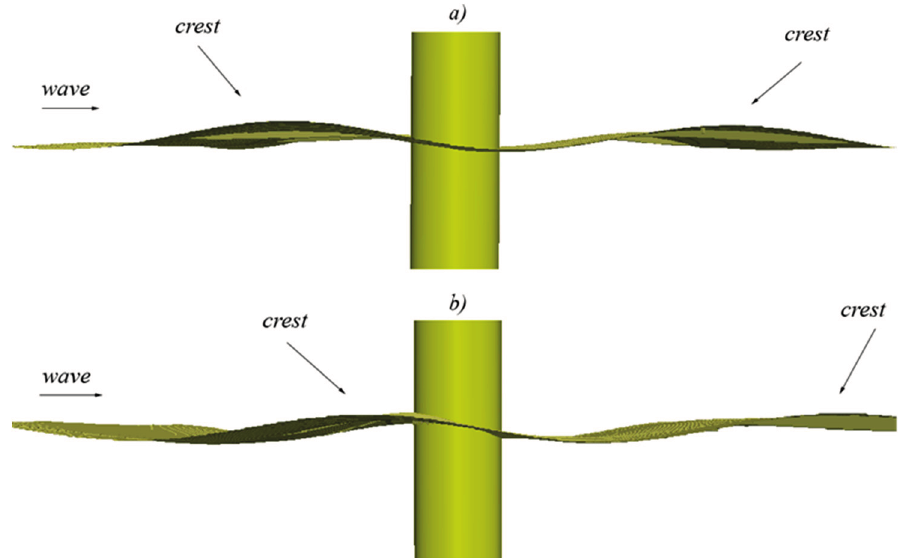
Figure 13. Velocity-potential-derived free-surface profile. Side view of